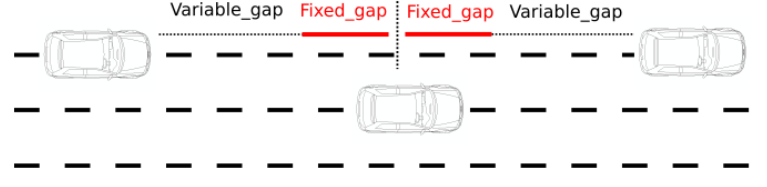
Figure 7. Safety distance to change lane.